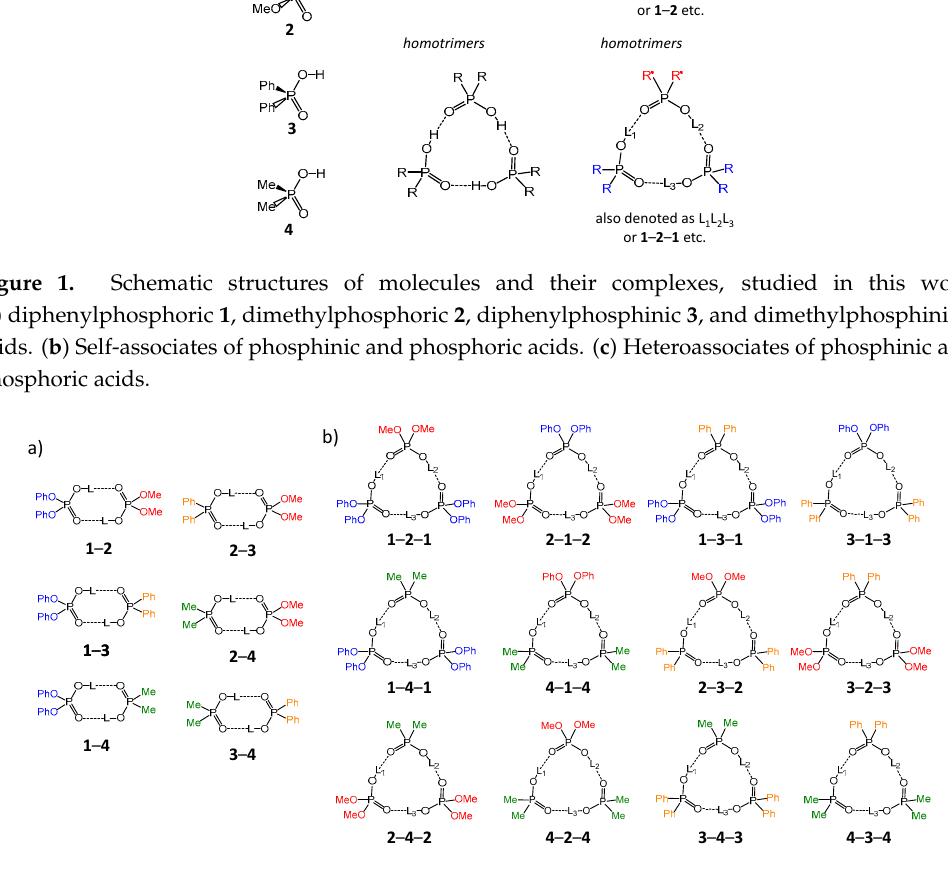
assigned to self-associates of acids 1 [15] and 2 [14]: cyclic dimers (marked with grey diamond symbols) and cyclic trimers (grey asterisks). These signals could be subtracted from the spectrum prior to its further deconvolution; the example of such deconvolution is shown in Figure 3 below the experimental spectrum. The experimental spectrum (black curve) and the trace of the sum of all deconvoluted signals (brown curve) match quite well. The remaining five low-field signals belong to heterodimer 1 - 2 and two heterotrimers, 1 - 2 - 1 and 2 - 1 - 2 (the structures are added to Figure 3). The 1 - 2 heterodimer gives rise to one bridging proton signal from two equivalent hydrogen bonds (they become equivalent due to the fast double proton